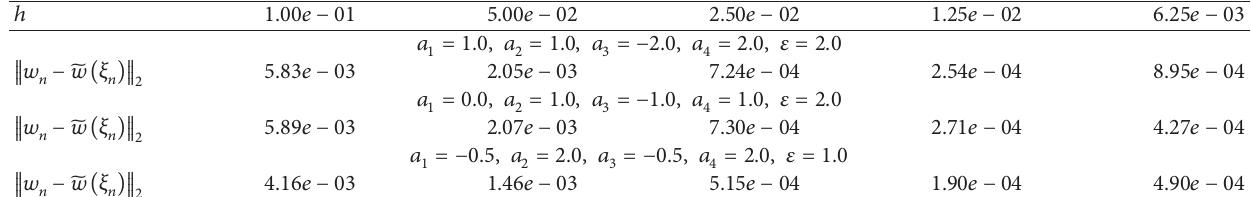
Table 1: Deviations of the numerical solution 𝑤 𝑛 from the exact solution ̃𝑤(𝜉 𝑛 ) (19). ℎ